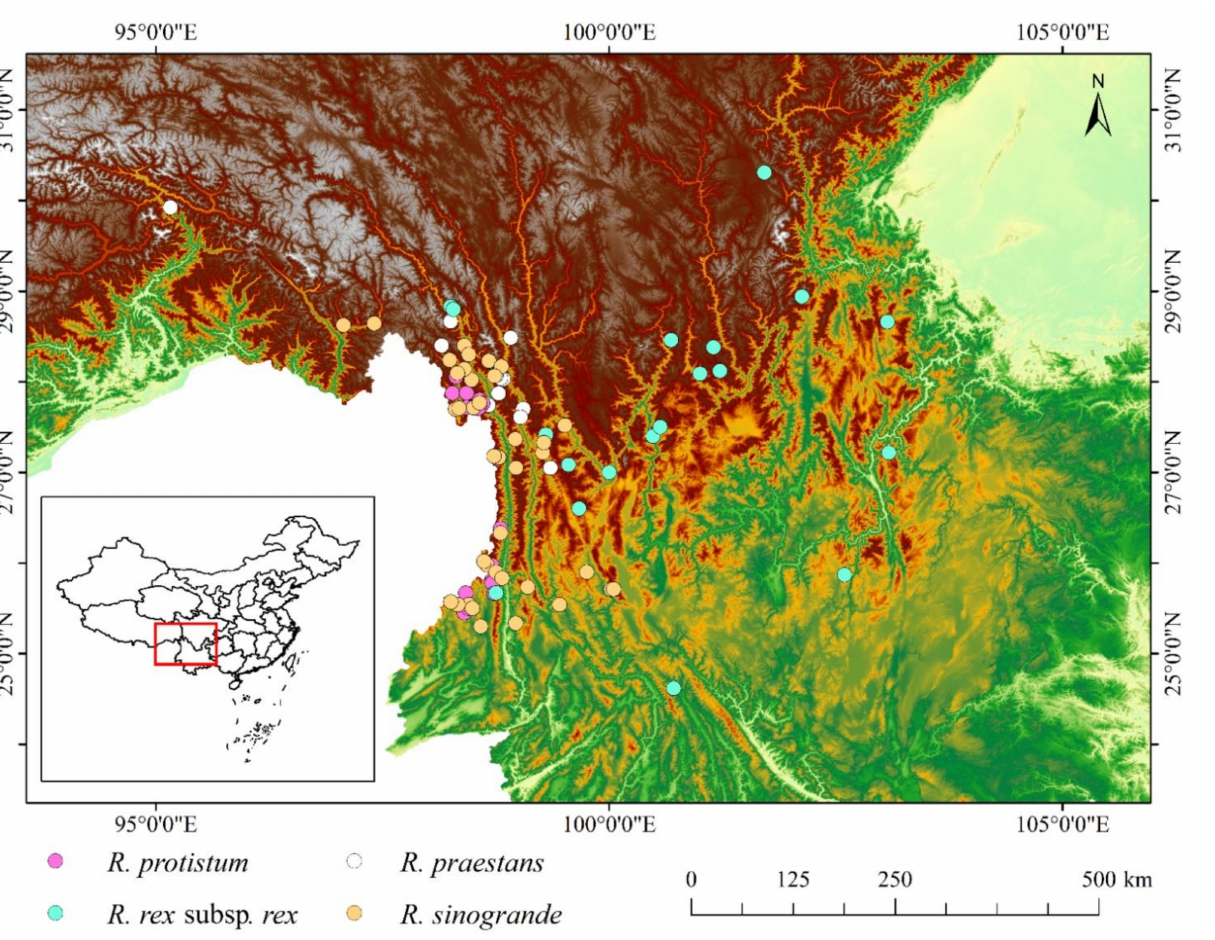
Figure 1. Occurrence points of four Rhododendron